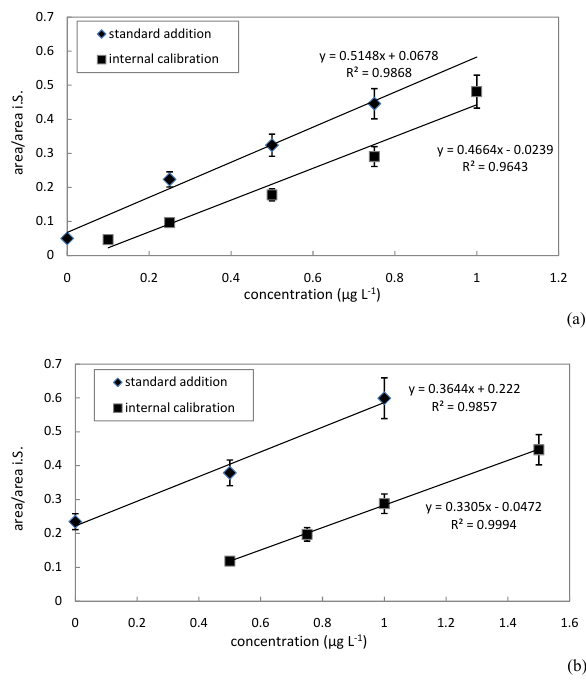
Fig. 3. Calibration curve for internal calibration and standard ad- dition for GLY (a) 100mL seawater sample, (b) 20mL aqueous extract of aerosol particle